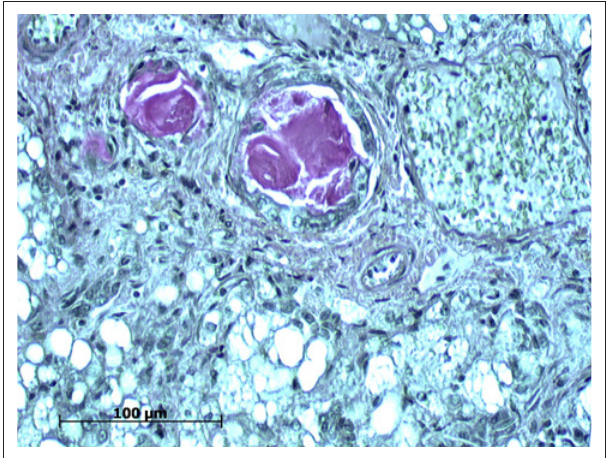
FIGURE 4: Mucicarmine staining of the blue-grey material found within the bile ductules and ducts observed in canine aflatoxicosis, identifying it as